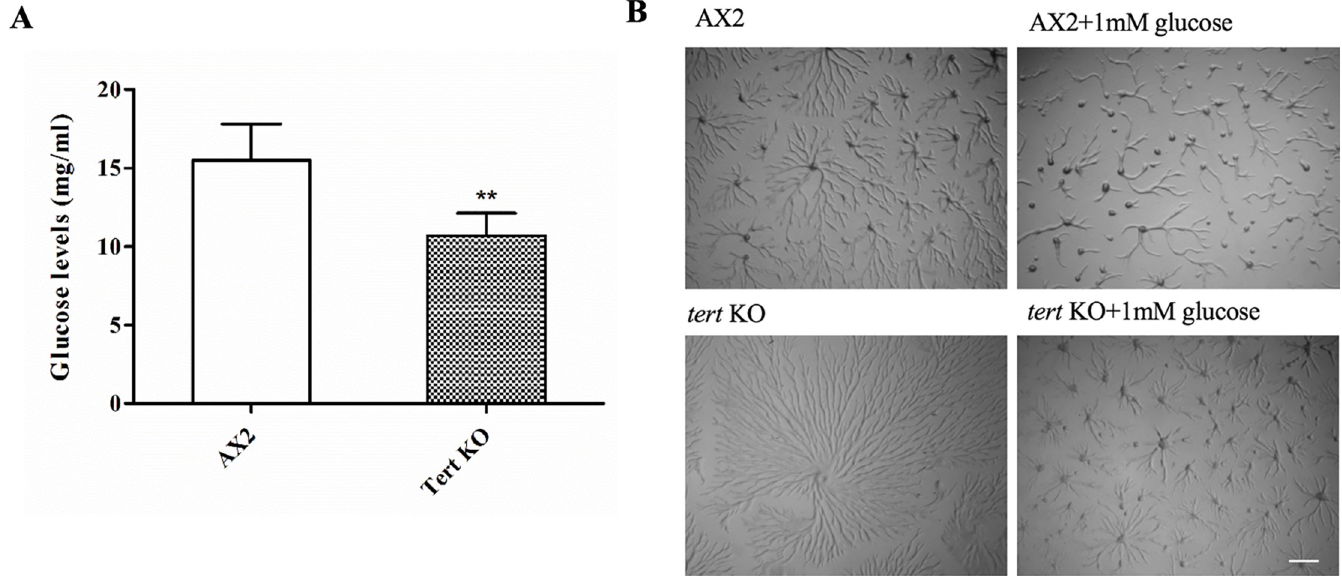
Fig 7. Effect of glucose on tert KO aggregate size. (A) Glucose levels during aggregation; (n = 3). (B) Wild-type AX2 and tert KO cells were developed on KK 2 agar plates in the presence of 1 mM glucose. Glucose rescues the streaming defect of tert KO. Scale bar: 0.5 mm; (n = 3). Level of significance is indicated as � p < 0.05, �� p < 0.01, ��� p < 0.001, and ���� p < 0.0001.